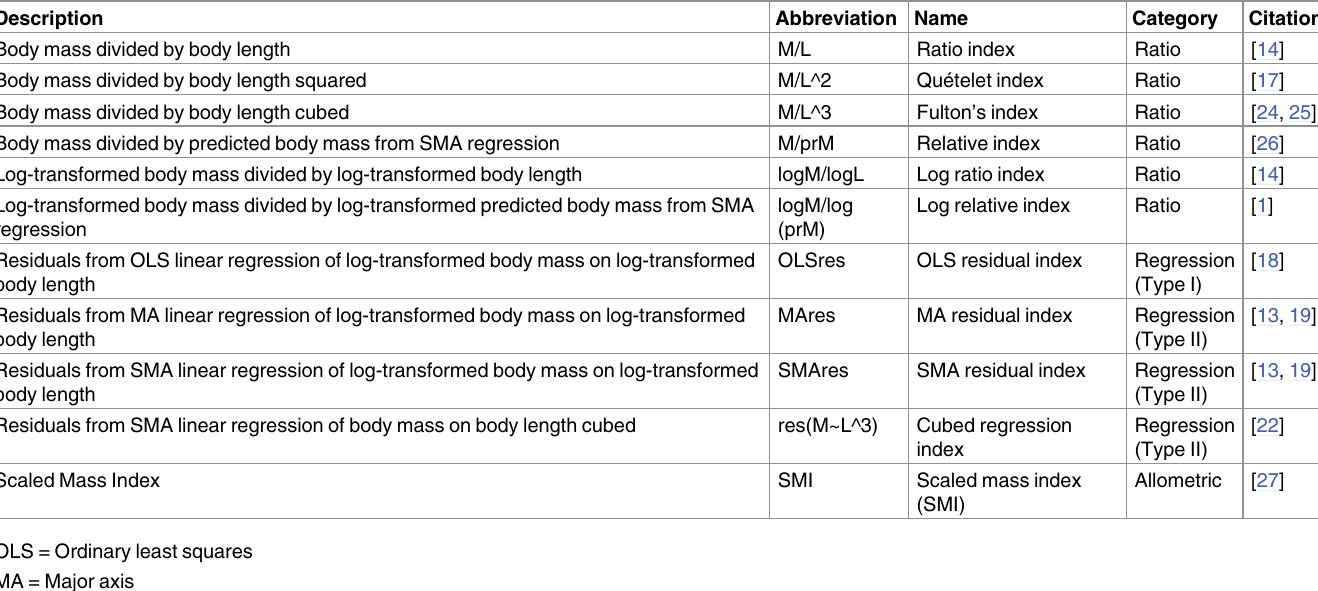
Table 1. Summaryof body condition indices (BCIs) used in this study. When available,the names were derived from the literature. Otherwise, we gave arbitrary, descriptivenames to unnamedBCIs to facilitate communication.